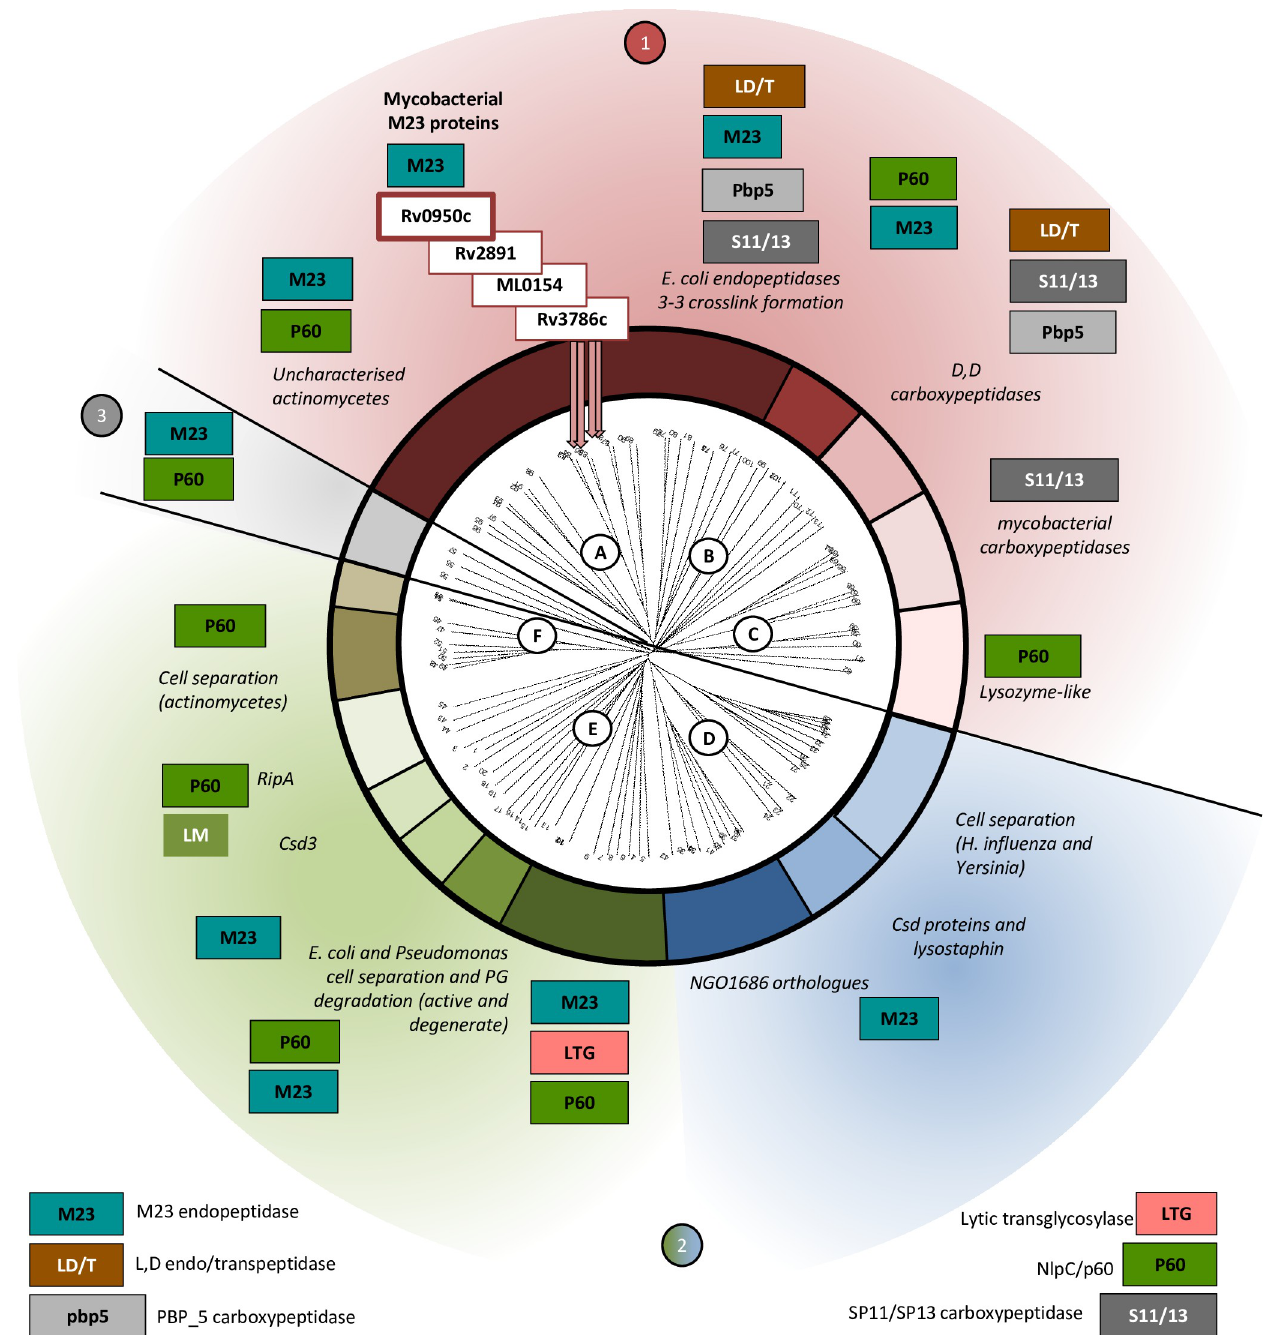
Fig 1. M . tuberculosis Rv0950c clusters with enzymes required for stem-peptide remodelling. Bacterial peptidoglycan hydrolases separate into three major clusters. The first, labelled 1—brown to light brown comprising sub-cluster A (uncharacterised homologues in actinomycetes, mycobacterial M23 and E . coli L,D-transpeptidases), B ( E . coli carboxypeptidases) and C (mycobacterial carboxypeptidases and B . subtilis lysozyme-like NlpC/p60 enzymes). The second major cluster, labelled cluster 2—blue to green comprising sub-cluster D ( Helicobacter and Neisseria cell-separation M23s and S . simulans lysostaphin), E ( E . coli EnvC and NlpD orthologues, M . tuberculosis RipA and other cell separation enzymes) and F (cell separation NlpC/p60 enzymes of actinomycetes). An outlying cluster, labelled 3 –grey, comprises three proteins: Neisseria meningitidis M23 proteins of unknown function, and M . avium paratuberculosis MAP1272c, a PG-binding, degenerate NlpC/p60 protein.